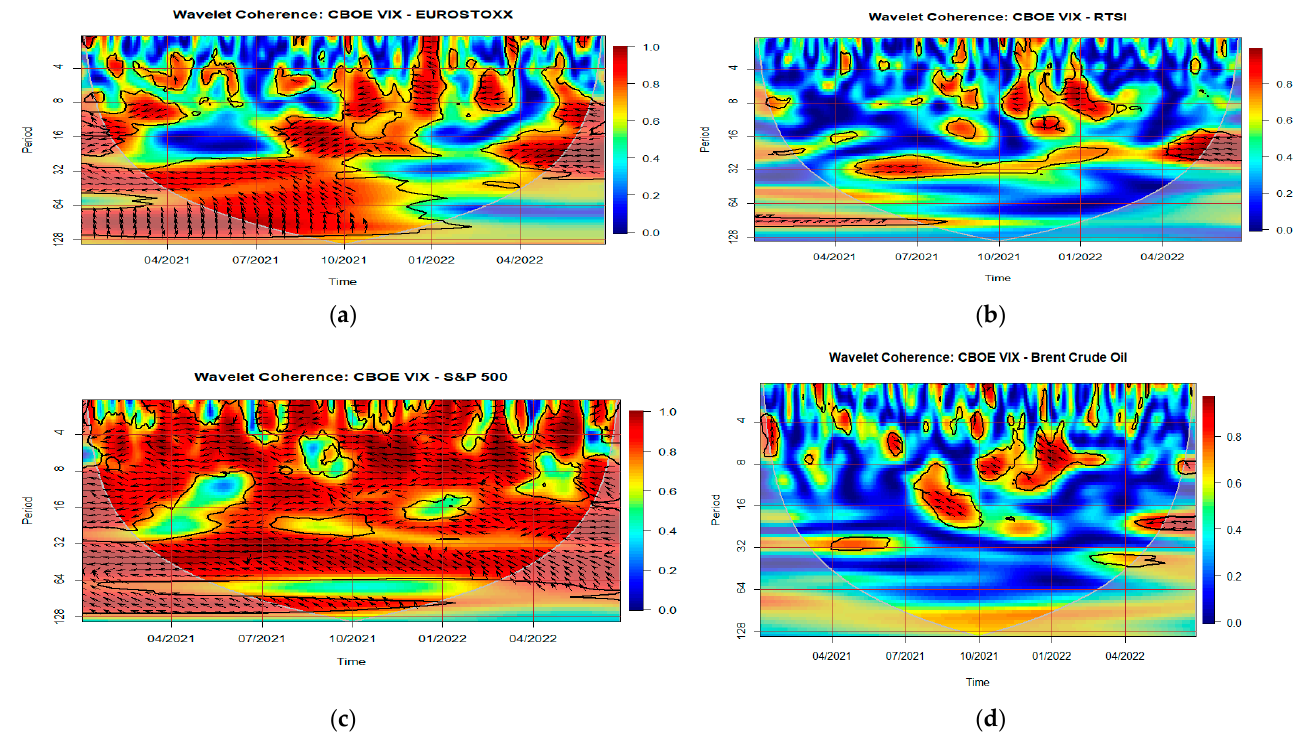
Figure 4. ( a – d ) Robustness tests for wavelet coherence between CBOE VIX and ( a ) Eurostoxx ( b ) RTSI, ( c ) S&P and ( d ) Brent crude